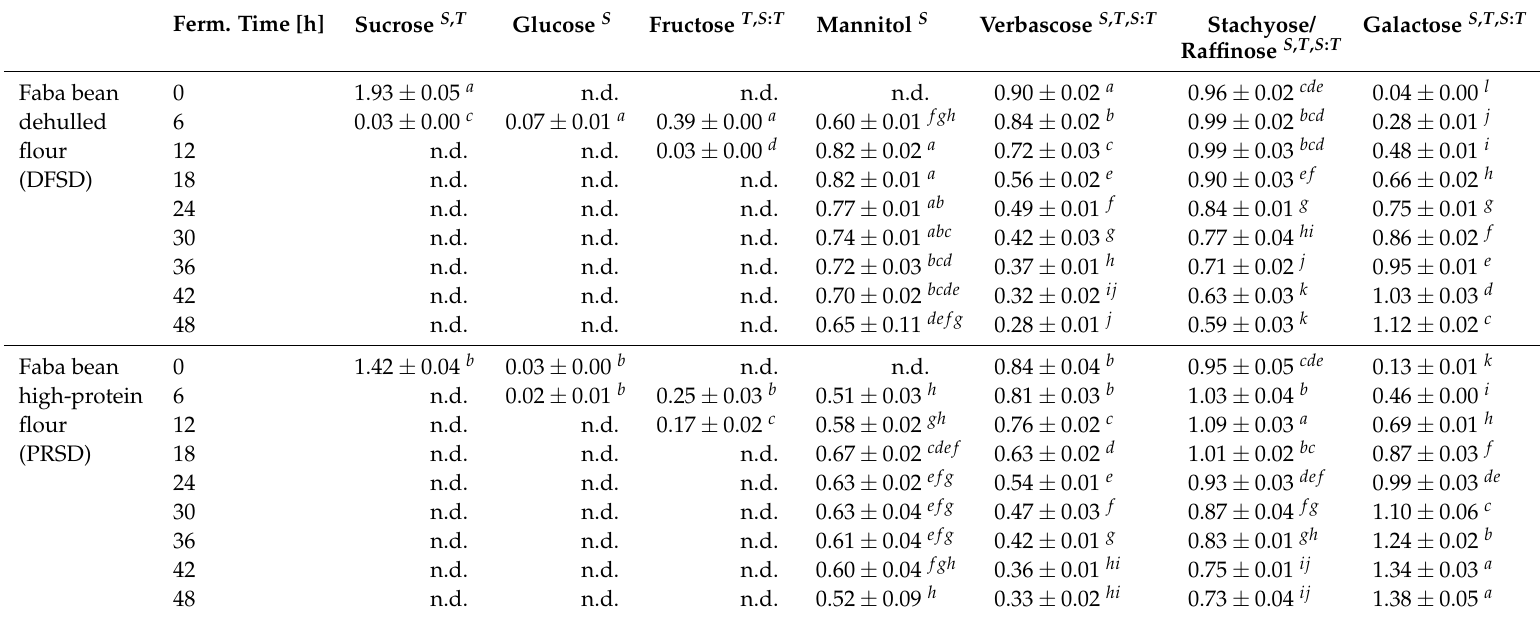
Table 3. Carbohydrate profile of faba bean fermentates, values expressed in